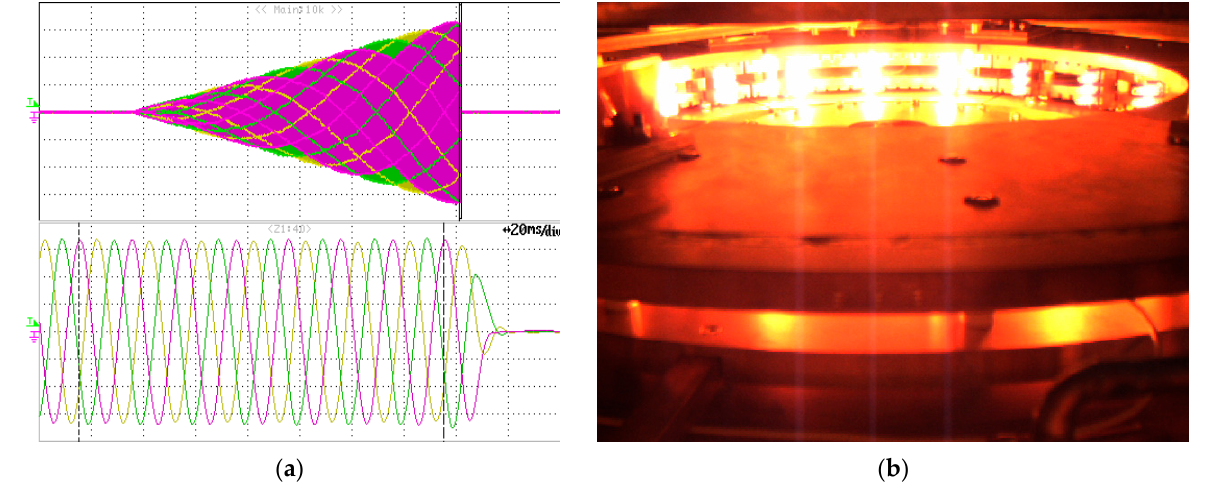
Figure 11. ( a ) Voltage measured in three phases of the cathode power supply during a voltage ramp; ( b ) Photo of the cathode taken during the heating phase.